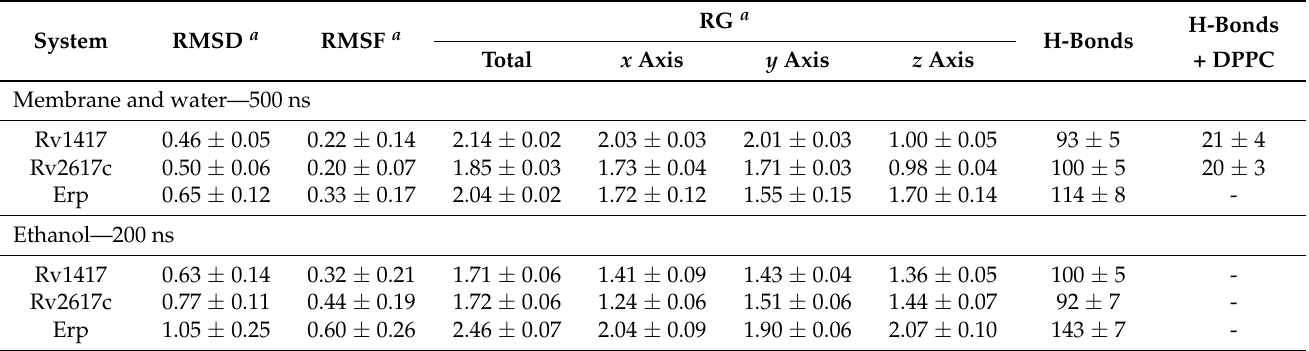
Table 2. Stability descriptors of the Mtb